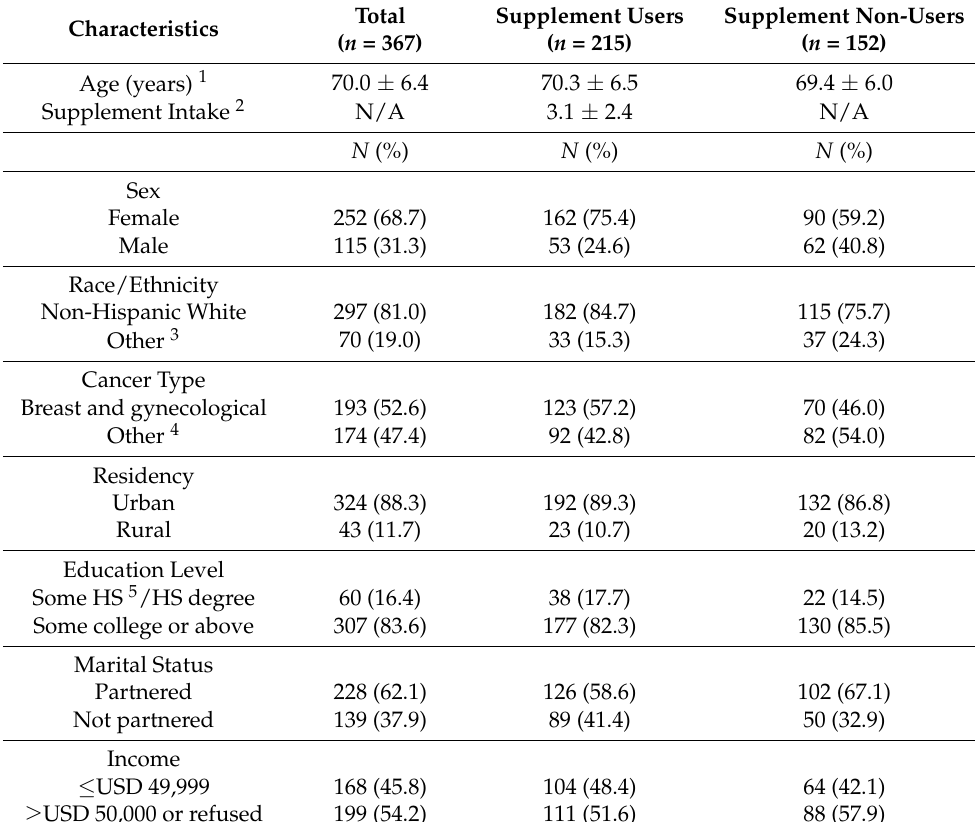
Table 1. Sample characteristics of older cancer survivors survey respondents ( n = 367).